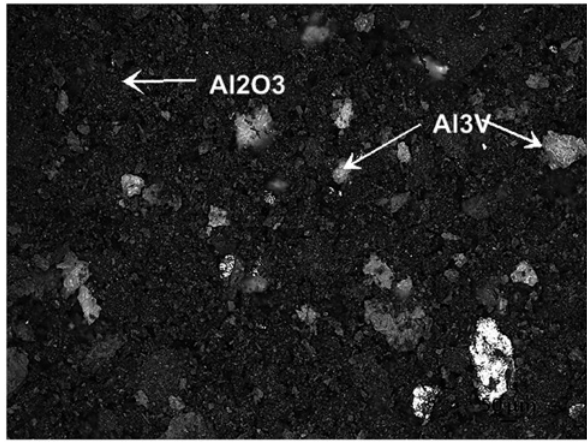
Figure 5: Scanning electron microscopy (SEM) image of extracted